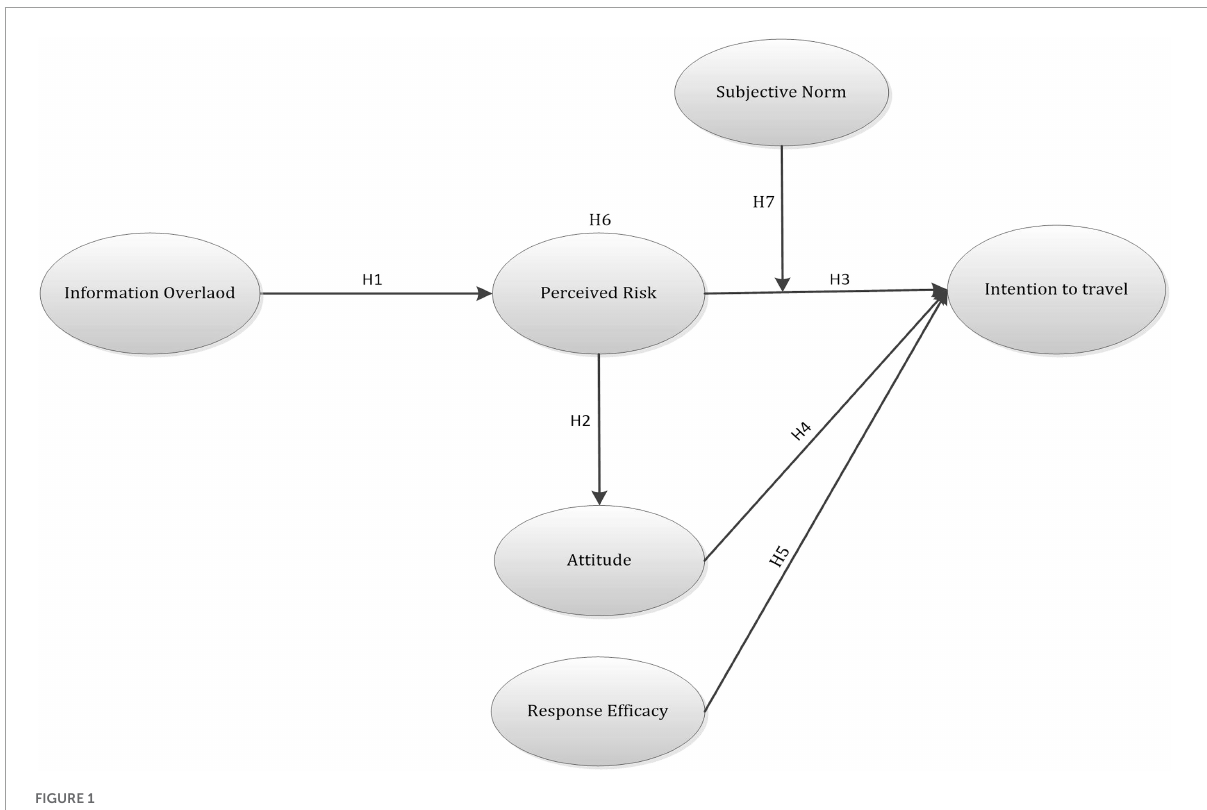
FIGURE1 Research